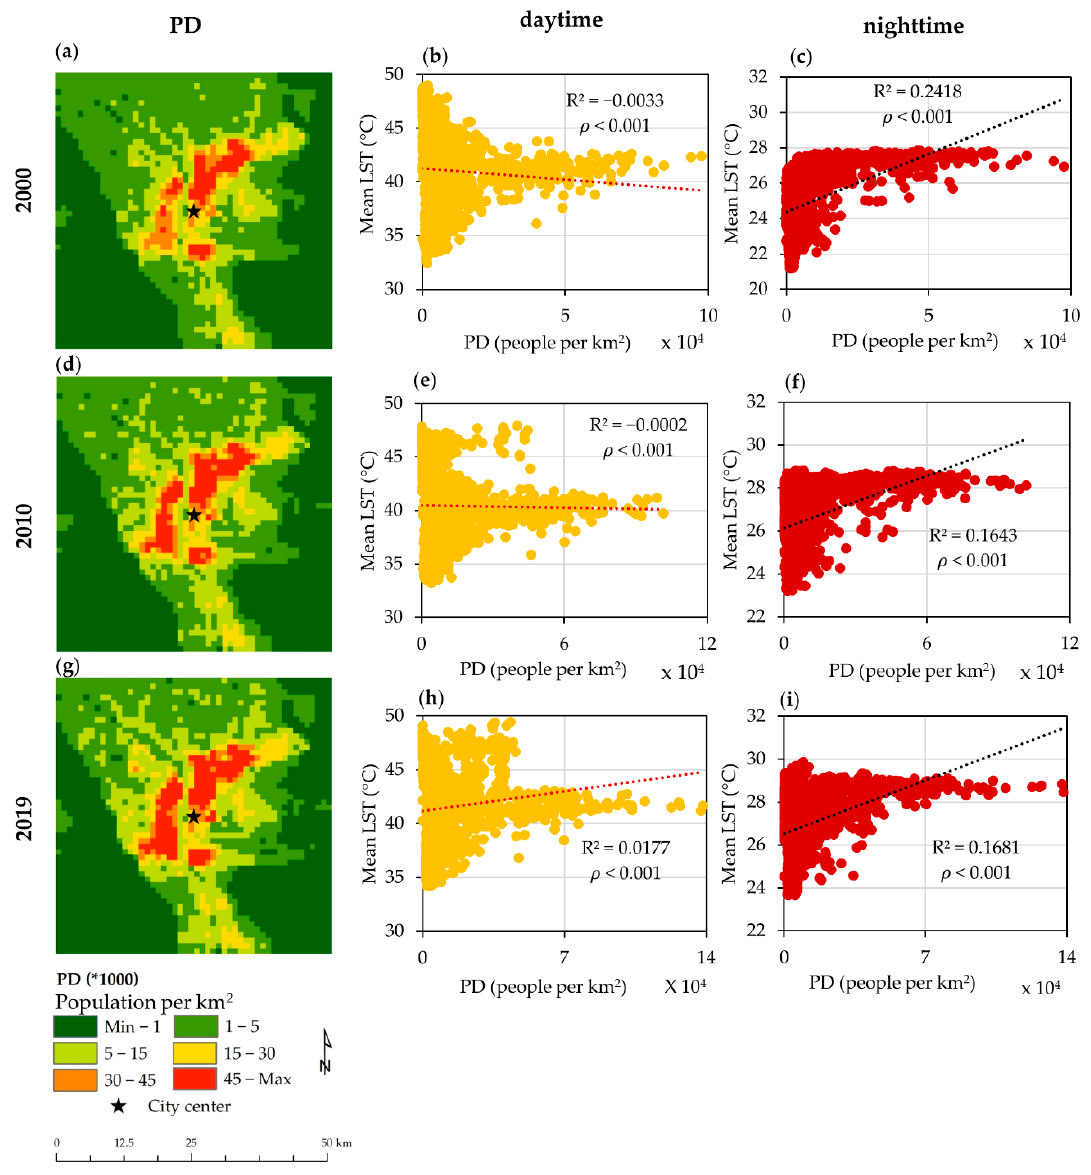
Figure 9. Population density (PD) of Greater Cairo and its environs: ( a ) PD in 2000; ( b ) daytime relationship between mean LST and PD in 2000; ( c ) nighttime relationship between mean LST and PD in 2000; ( d ) PD in 2010; ( e ) daytime relationship between mean LST and PD in 2010; ( f ) nighttime relationship between mean LST and PD in 2010; ( g ) PD in 2019; ( h ) daytime relationship between mean LST and PD in 2019; and ( i ) nighttime relationship between mean LST and PD in